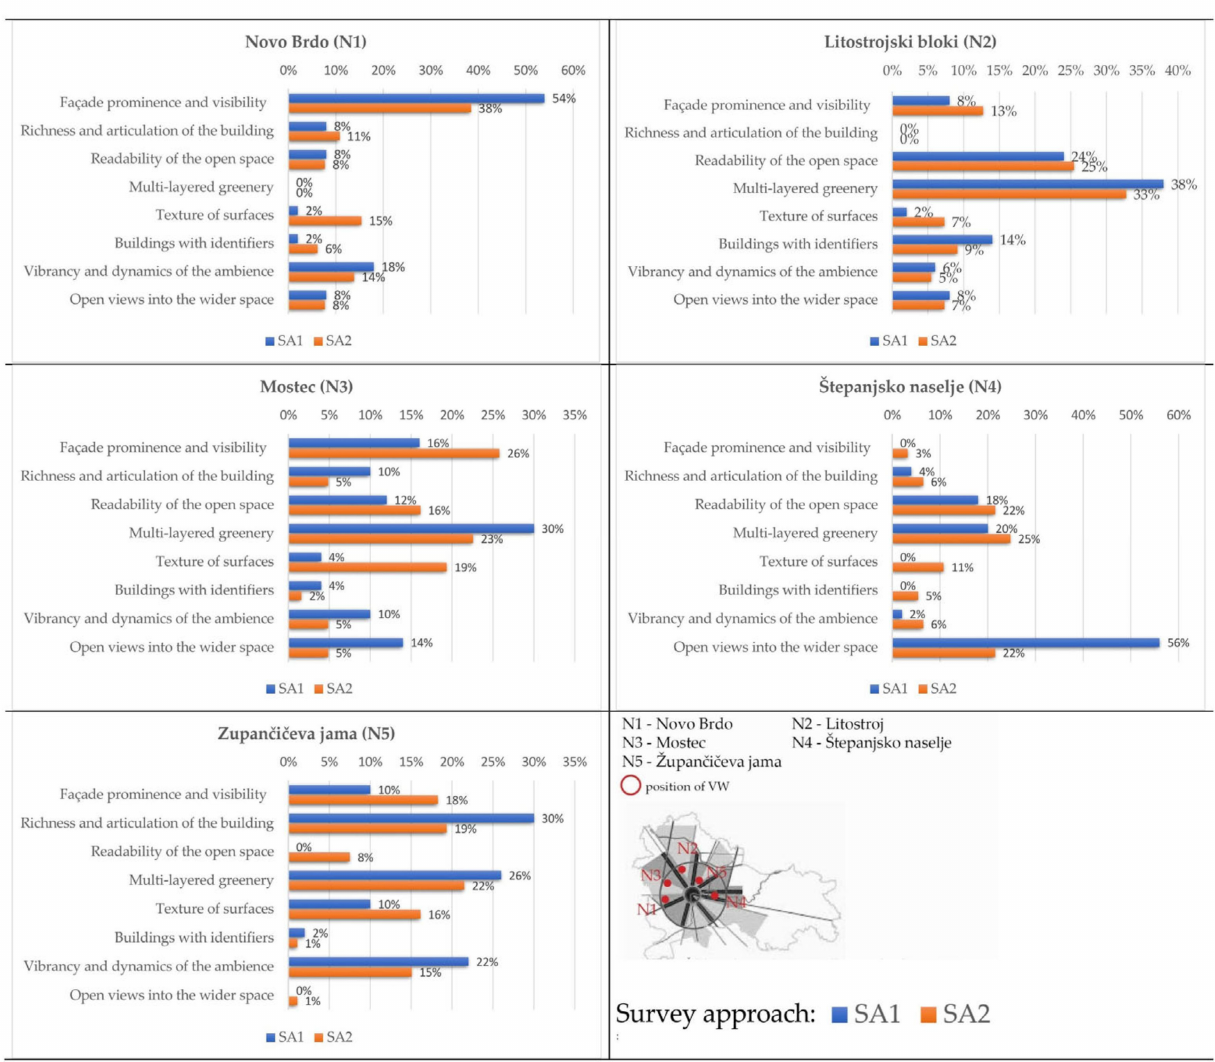
Figure 3. Relative number of responses on perception of imageability according to neighborhood and survey